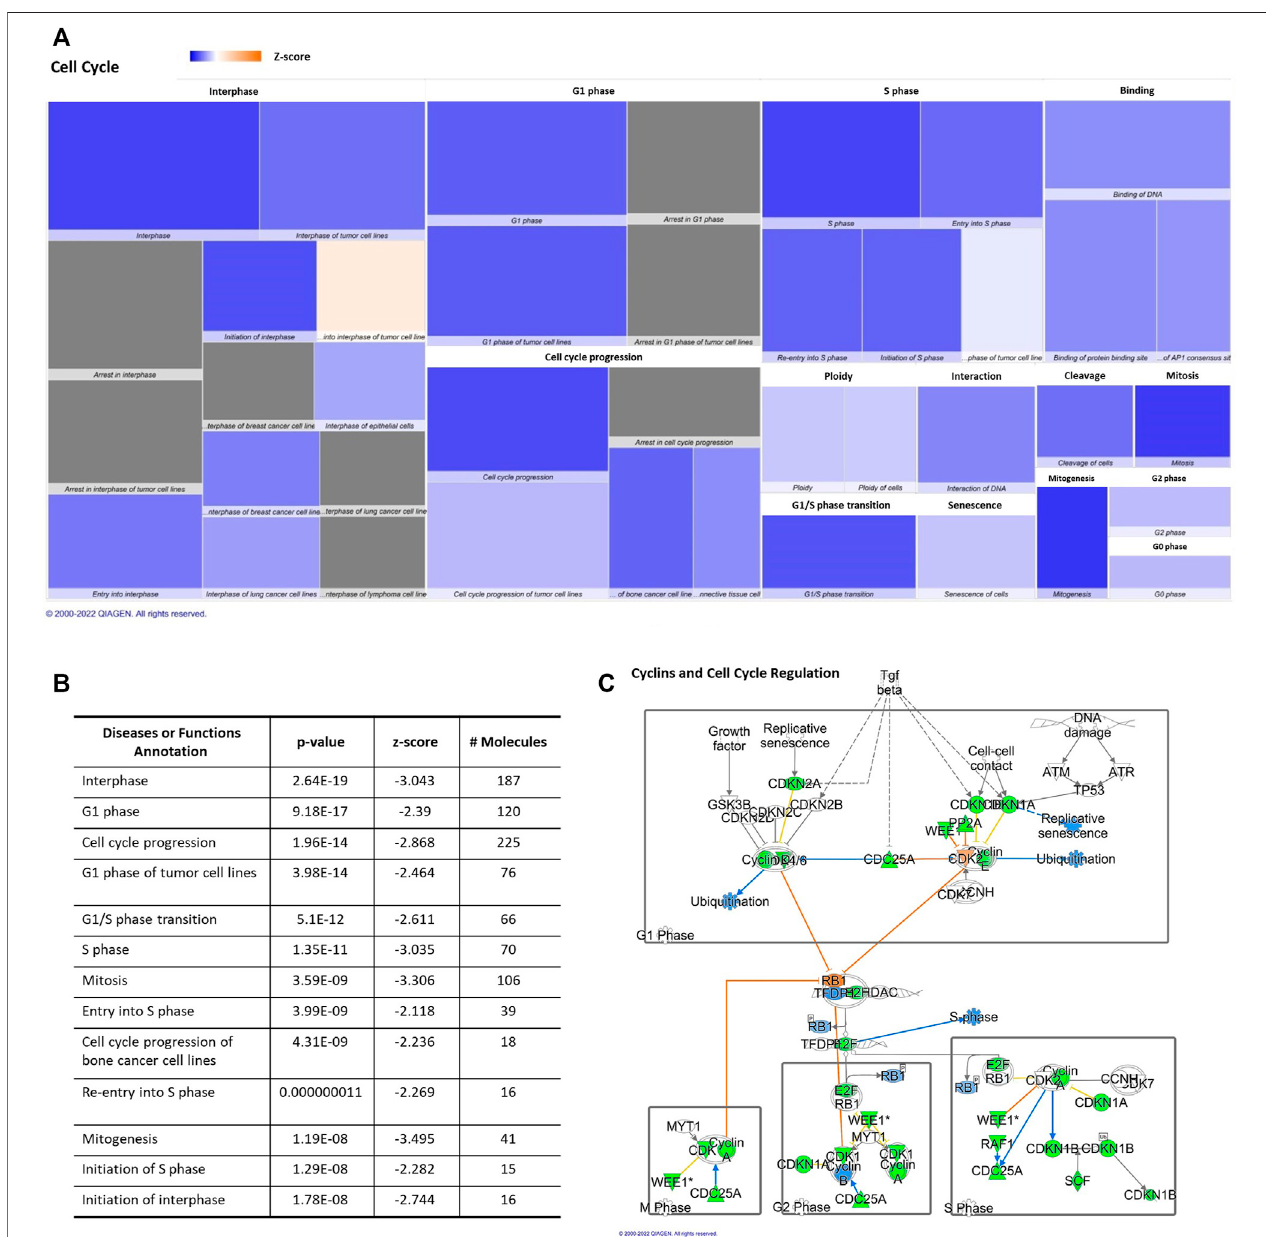
FIGURE 2 | Aging-induced predicted effects of miRNAs content in circulating adipocyte-derived EVPs on Cell Cycle. (A) Heat map of the “ Cell Cycle ” among the top “ molecular and cellular functions ” categories. Each box represents one molecular and cellular function, its size represents gene enrichment. The heatmap is according to z-score values, where the color indicates the predictedincrease or decrease status; higher z-scores would be represented by orange indicating activation, and lower z-scores was represented by blue indicating inhibition. (B) Annotations of the “ Cell Cycle ” category are impacted signi fi cantly by aging process, their z score, number of affected molecules, and p values. (C) mRNA Targets of microRNAs impacted by aging in circulating adipocyte-derived EVPs related with cell cycle canonical pathway. Green color indicates a predicted negative effect on mRNA targets, such as enzymes and transcription factors. miRNA-15b-5p targets cyclins (CCNs), CCND1, CCND2, CCND3, CCNE1, cyclin-dependent kinases (CDK) CDK6; miR-24-3p targets CCNA2, CDK1, and CDK4, while miR-92b-3p targets CCNE2. miR-15b-5ptargetstranscriptionfactors,suchasE2Fsisoforms,namelyE2F3andE2F7,whilemiR-24-3p targetsE2F2.E2Fisactivatedwhenretinoblastoma proteins (pRb) are phosphorylated and it dissociates from E2F ( Table 1 ).